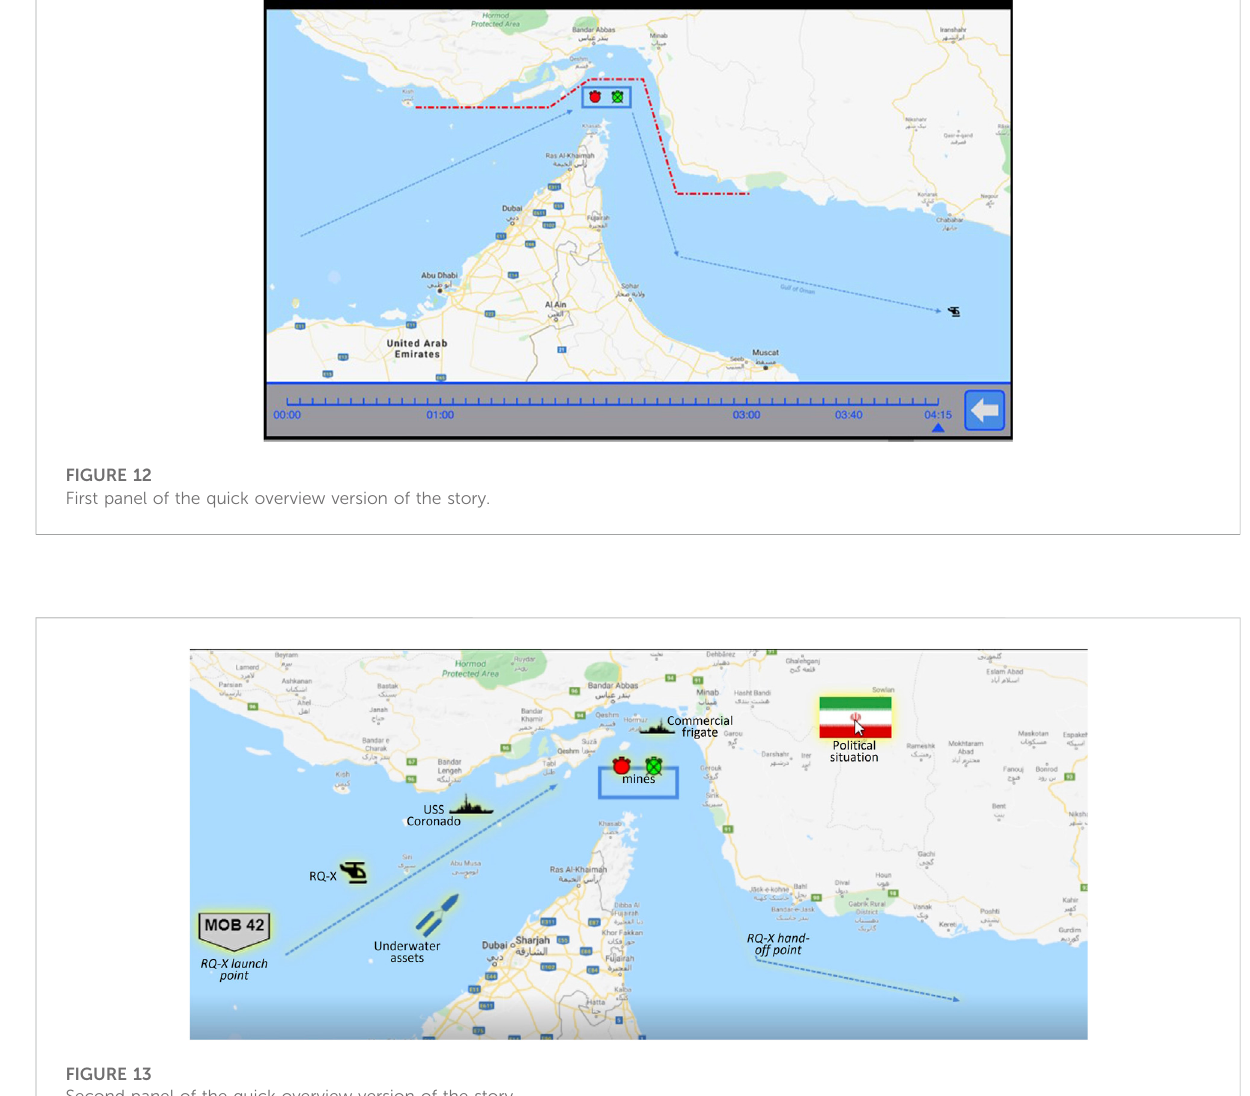
timeline (4 h, 15 min), showing both successful (green circle) and unsuccessful (red circle) mine destruction by the RQ-X. The red dotted line is the keep-out or “ no- fl y ” zone.